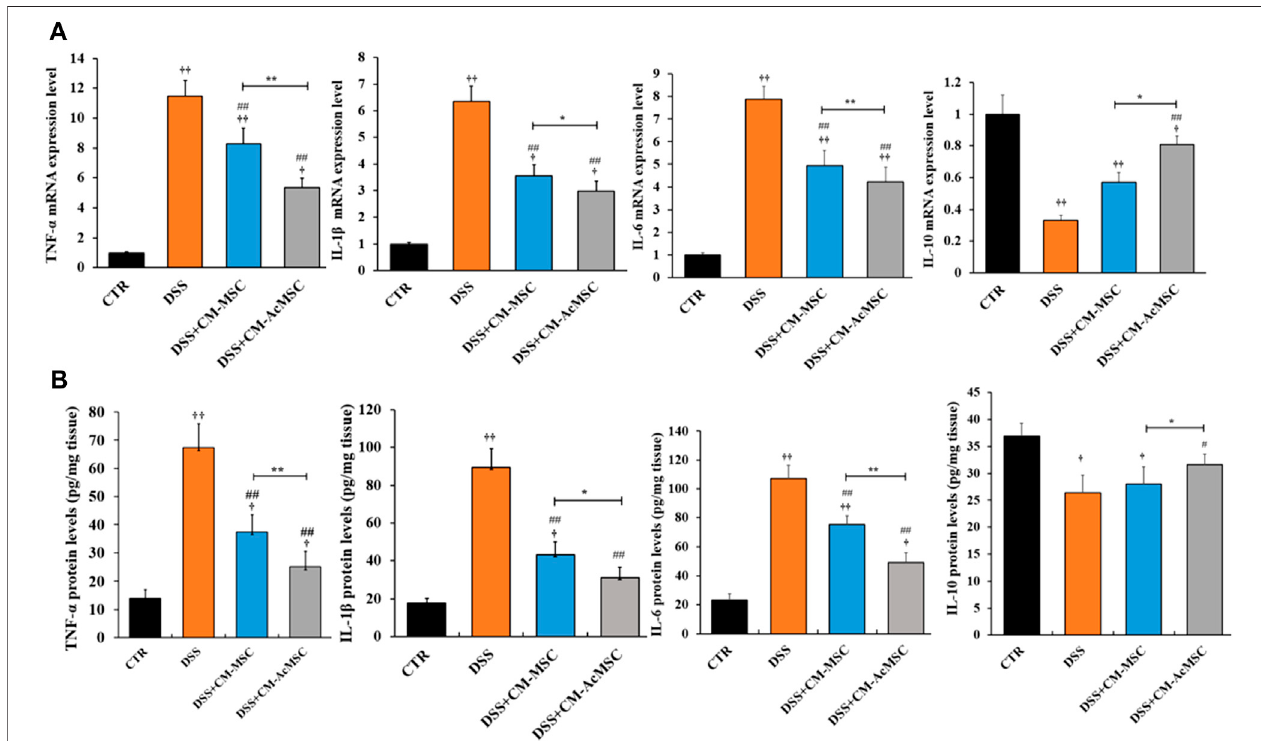
FIGURE 5 | CM-AcMSC inhibited the expression and production of cytokines in colon tissues, n (cid:2) 6. (A) The mRNA levels ofcytokines such as TNF- α , IL-1 β , IL-6, and IL-10 were determined by quantitative reverse-transcription PCR, normalized by β -actin. (B) The protein levels of TNF- α ,IL-1 β , IL-6, and IL-10 were detected by ELISA. Data are presented as means ± SEM. † p < 0.05, †† p < 0.01 vs CTR; # p < 0.05, ## p < 0.01 vs DSS; * p < 0.05, ** p < 0.01.